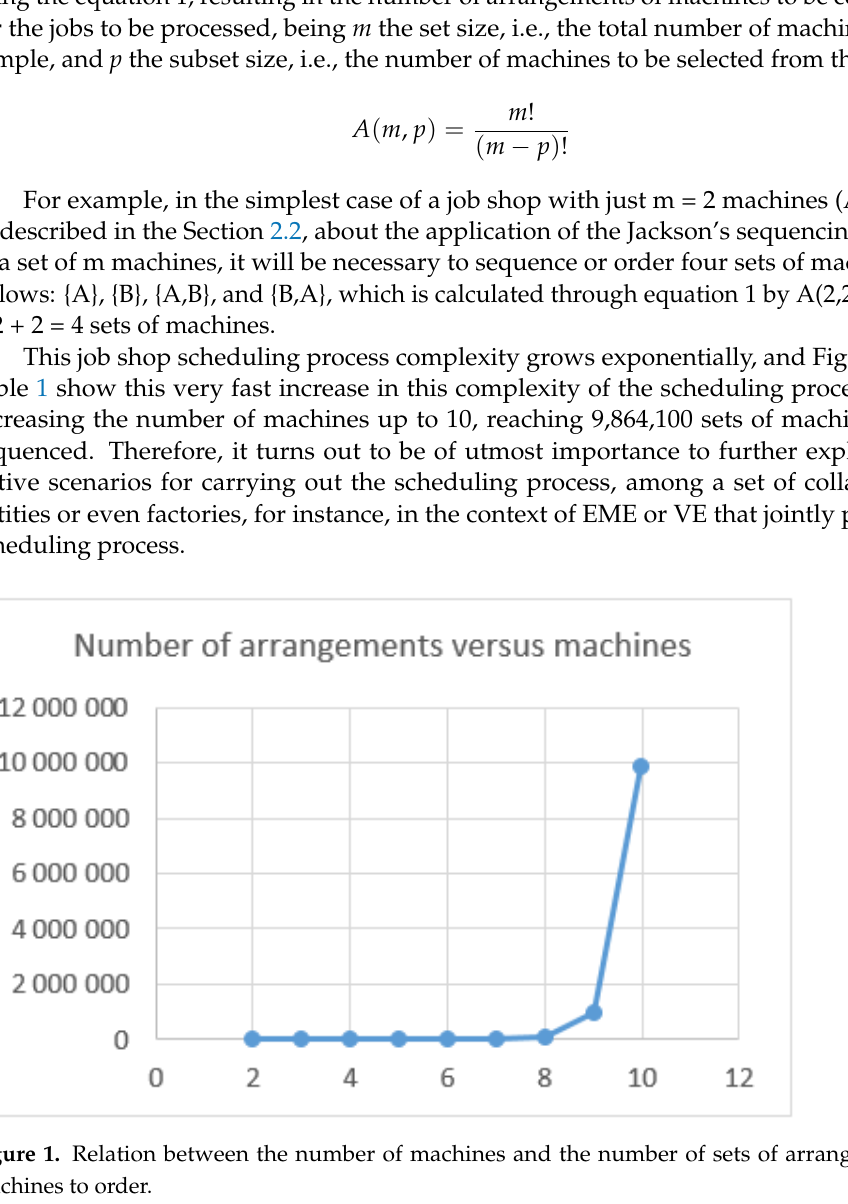
Table 1. Problem complexity.